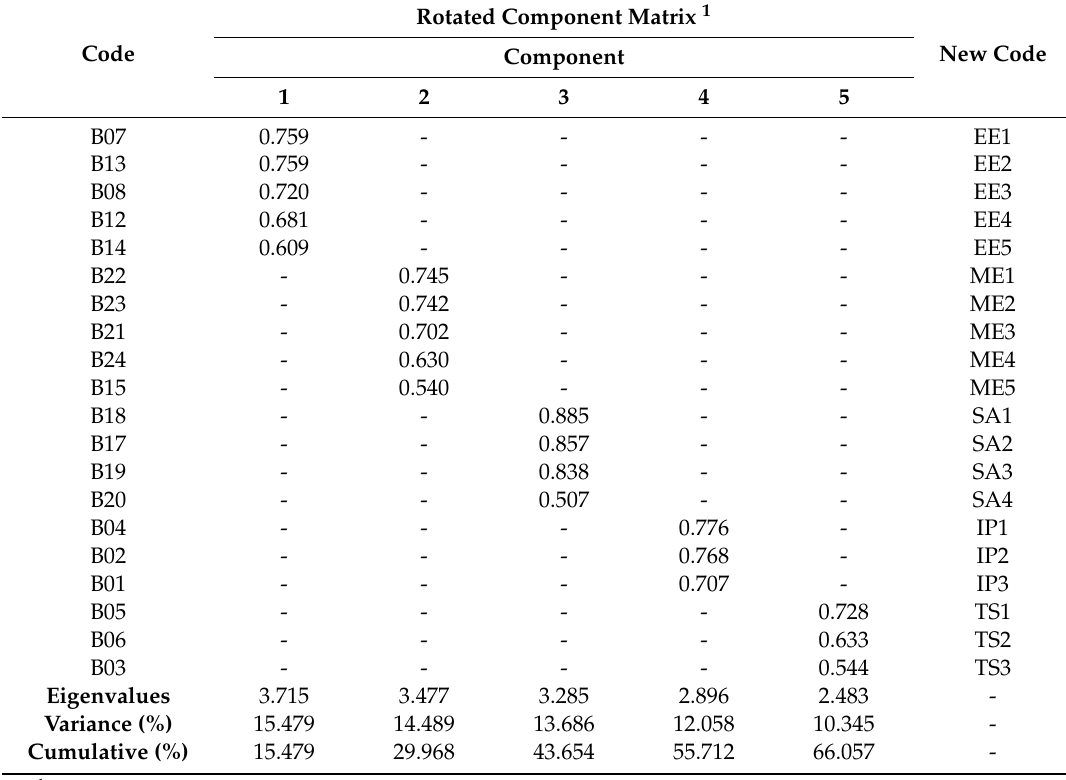
Table 5. Factor analysis result of the selected potential